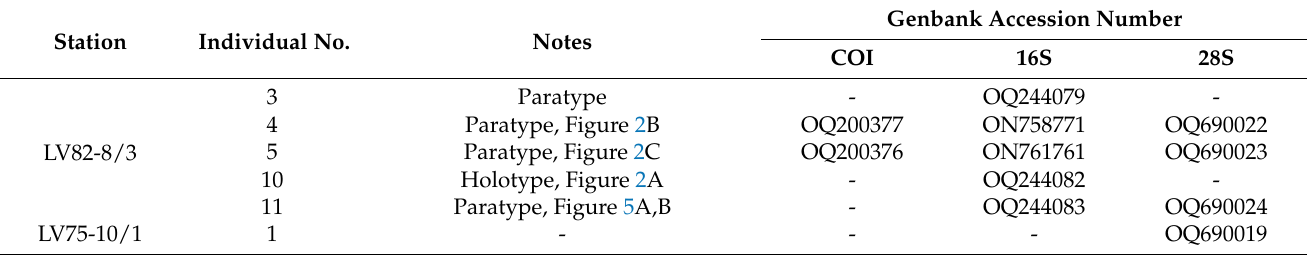
Table 3. Genbank accession numbers for molecular sequences of gastropods from Bering Sea.